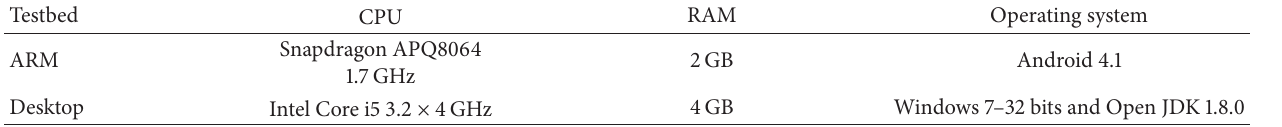
Table 2: Detailed platform parameters.